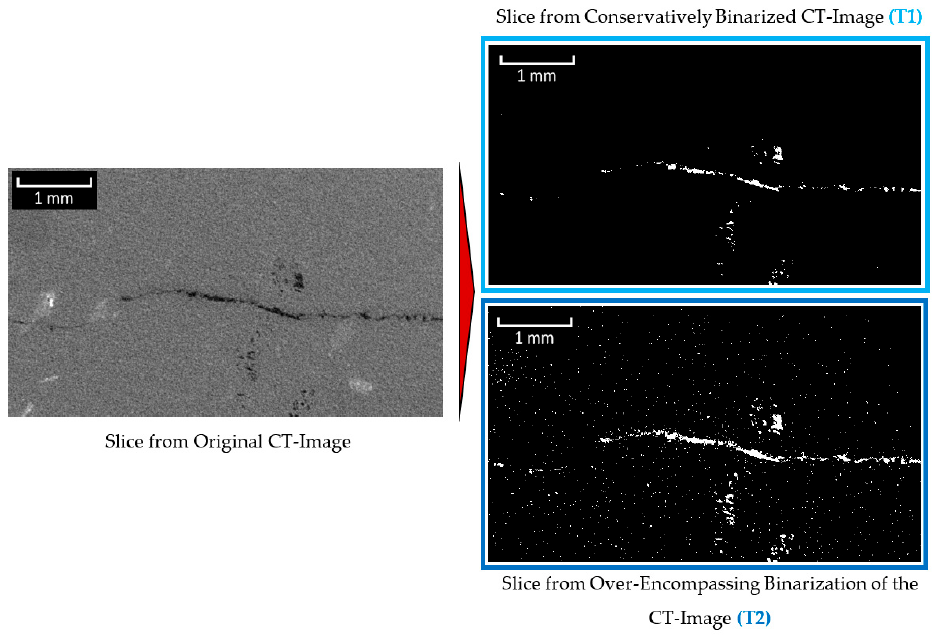
Figure 5. Binarization of greyscale image using the conservative and over-encompassing thresholds identified using the automated selection method (based on figure in [10]).